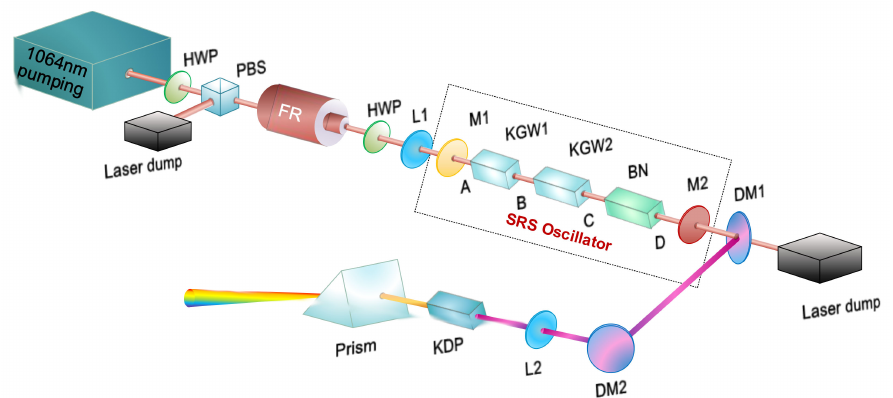
Figure 1. Schematic of the discretely tunable multiwavelength visible laser based on second harmonic generation (SHG), sum frequency generation (SFG) and cascaded stimulated Raman scattering (SRS) system. M1 and M2 form the SRS cavity. HWP: half wave plate; PBS: polarization beam splitter; FR: Faraday rotator; L: lens, M: mirror; BN: Ba(NO 3 ) 2 ; DM: dichroic